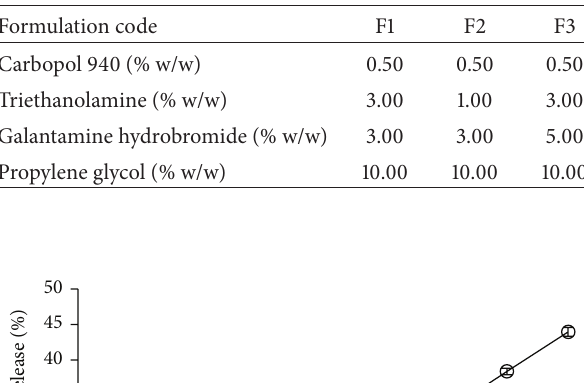
Figure 6: Formulation without